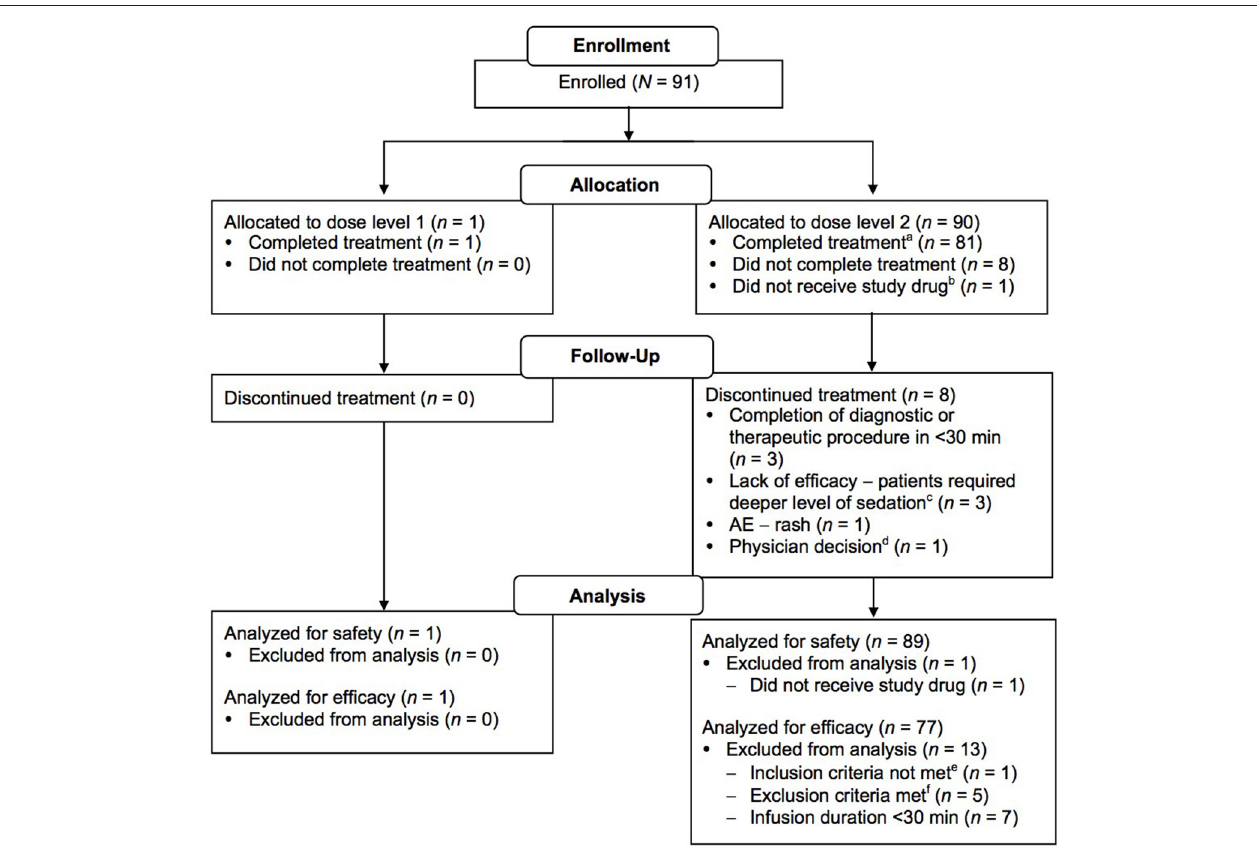
FIGURE 2 | CONSORT diagram. a Patients who received study drug infusion for at least 30 min. b Patient was not treated due to administrative reasons (approval to prepare study drug could not be obtained within the 2-week period between enrollment and treatment). c Patients unable to be sedated adequately with protocol medications; converted to propofol sedation. d Error in drug administration and clamp never released, no drug reached patient. Physician proceeded with alternative sedation. e Patient was < 17 years of age. f Three patients had hypotension immediately before dosing; two patients had participated in an experimental/investigational drug study within 30 days prior to study drug administration.